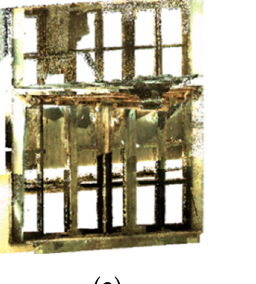
Figure 10. Creating the object library (window) starting from point cloud ( a ) to 3D BIM family ( b ).